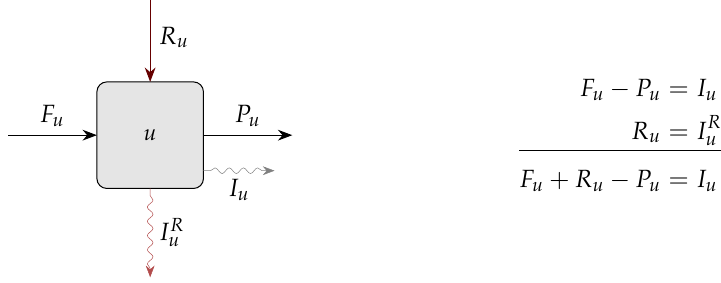
Figure 6. Fuel–Product–Waste schema for a generic productive